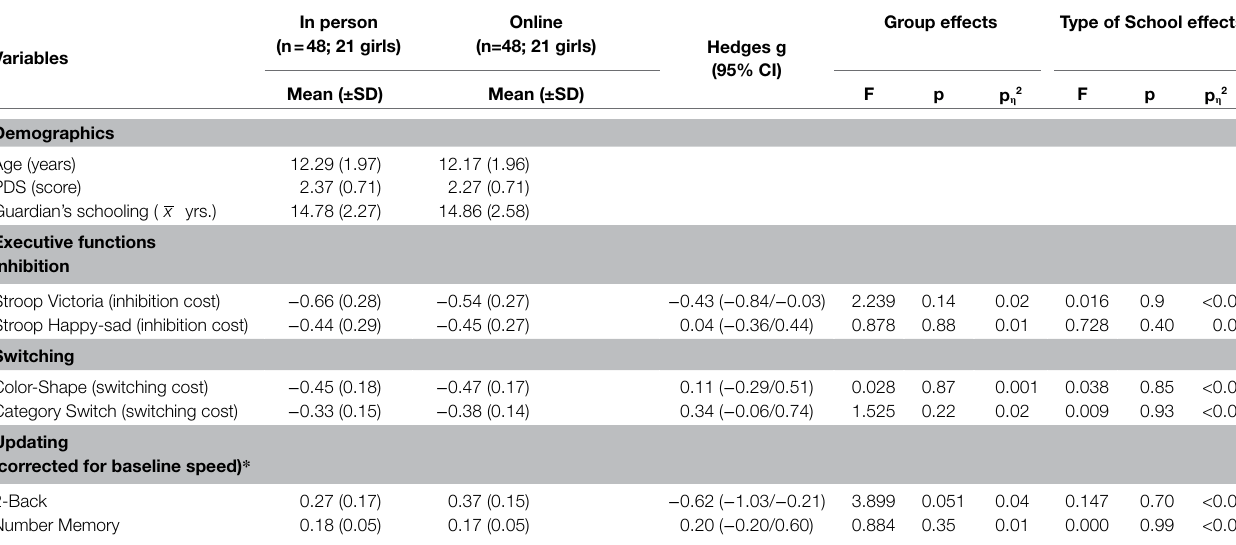
TABLE 2 | Descriptive statistics of demographics and Rate Correct Scores (RCS: accuracy divided by total time in s) of executive functions performance.